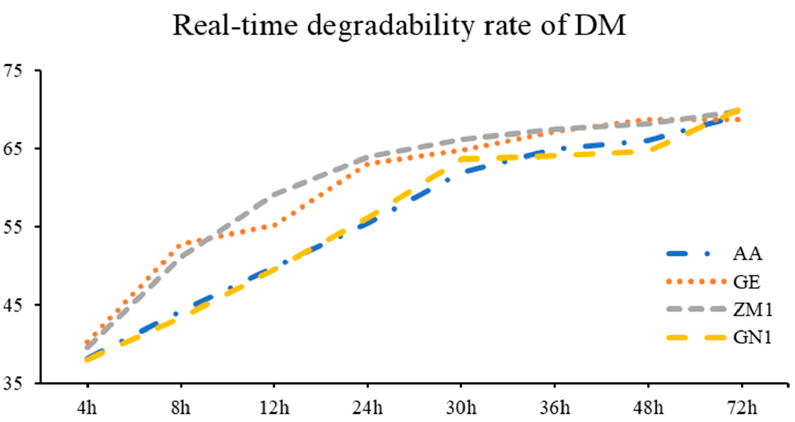
Figure 2. The real-time degradability rate of DM in different alfalfa hay cultivars. AA: American